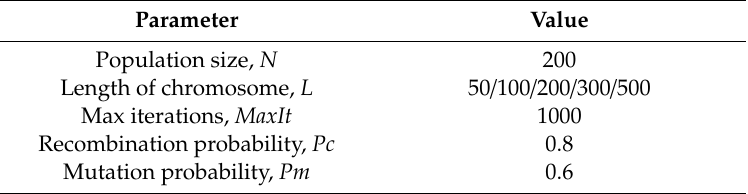
Table 4. Parameters of the non-dominated sorting genetic algorithm II (NSGA-II